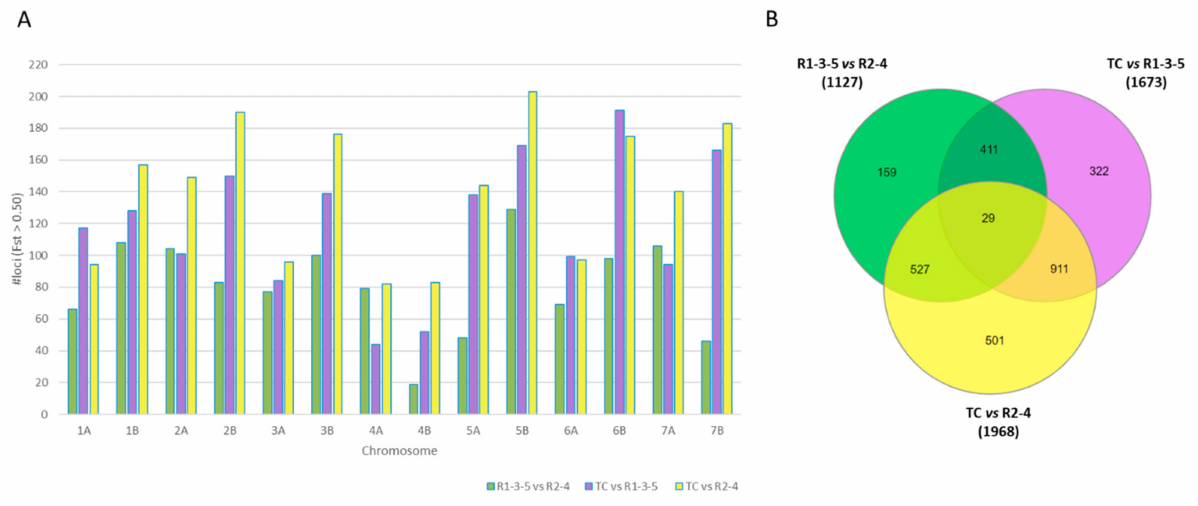
Figure 4. ( A ) Distribution of divergent loci ( F ST > 0.50) along the 14 chromosomes of durum wheat. ( B ) Venn diagram showing the number of divergent SNP markers detected in TC vs. R1-3-5, TC vs. R2-4 and R1-3-5 vs.